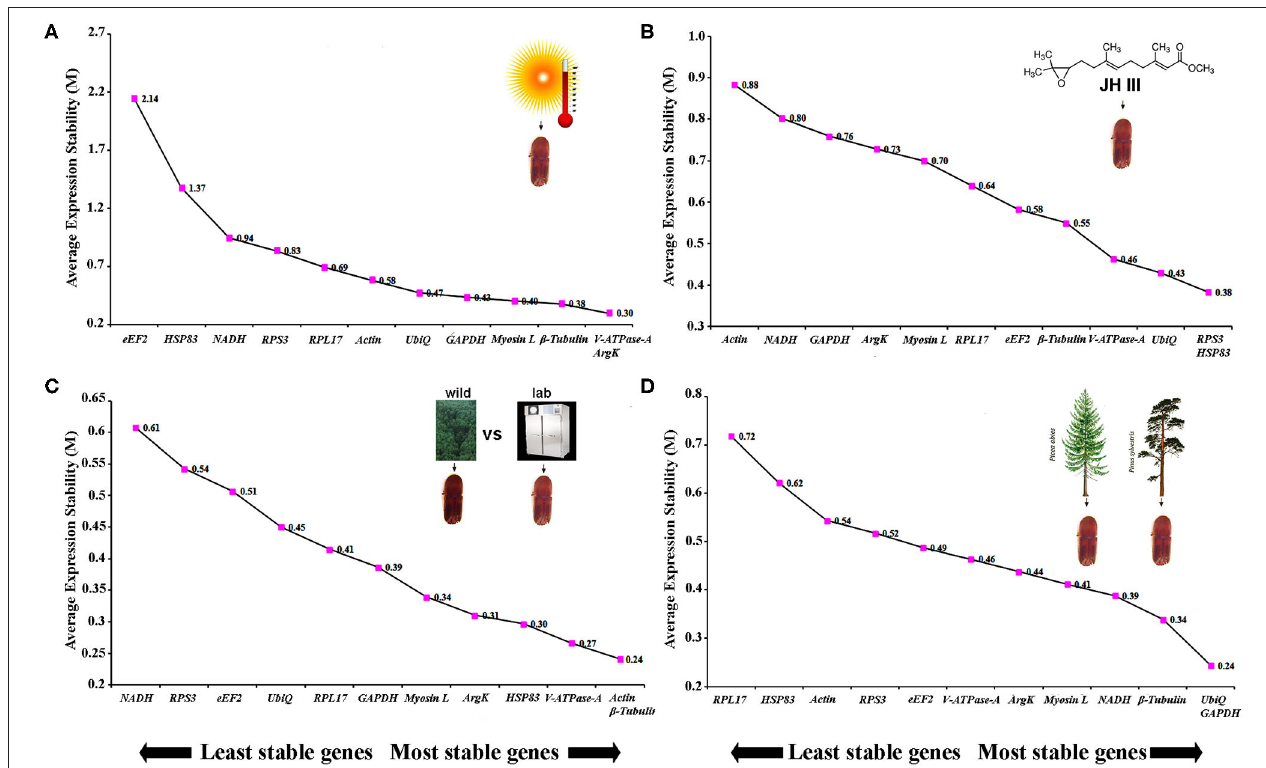
FIGURE 3 | The average expression stability values (M) of 12 reference genes under diverse conditions were calculated by geNorm from the least stable (left) to the most stable (right). (A) Temperature, (B) juvenile hormone III, (C) laboratory-reared vs. wild beetles, and (D) pine-fed vs. spruce-fed beetles.